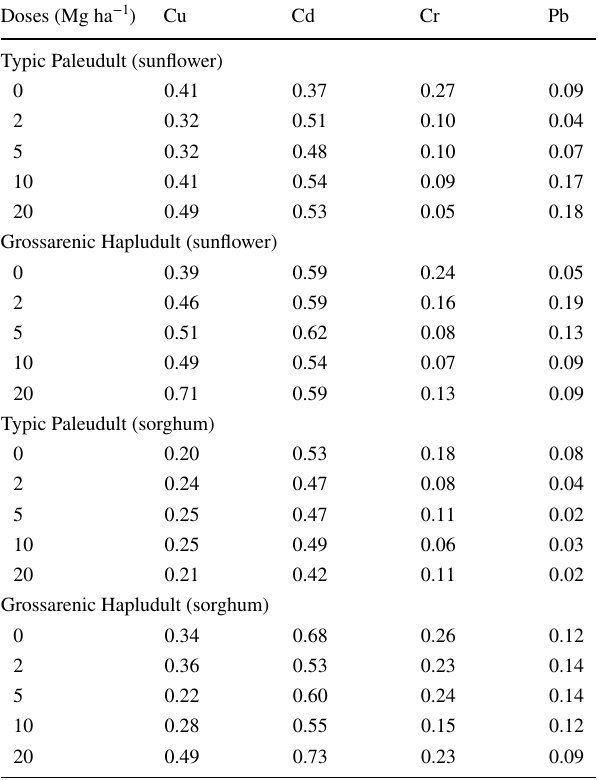
Table 3 Translocation factor of Cu, Cd, Cr, and Pb in sunflower and sorghum plants cultivated in Typic Paleudult and Grossarenic Hap- ludult soils under the amendment of industrial landfill sludge (ILS) at 0, 2, 5, 10, and 20 Mg ha −1 doses Doses (Mg ha −1 )